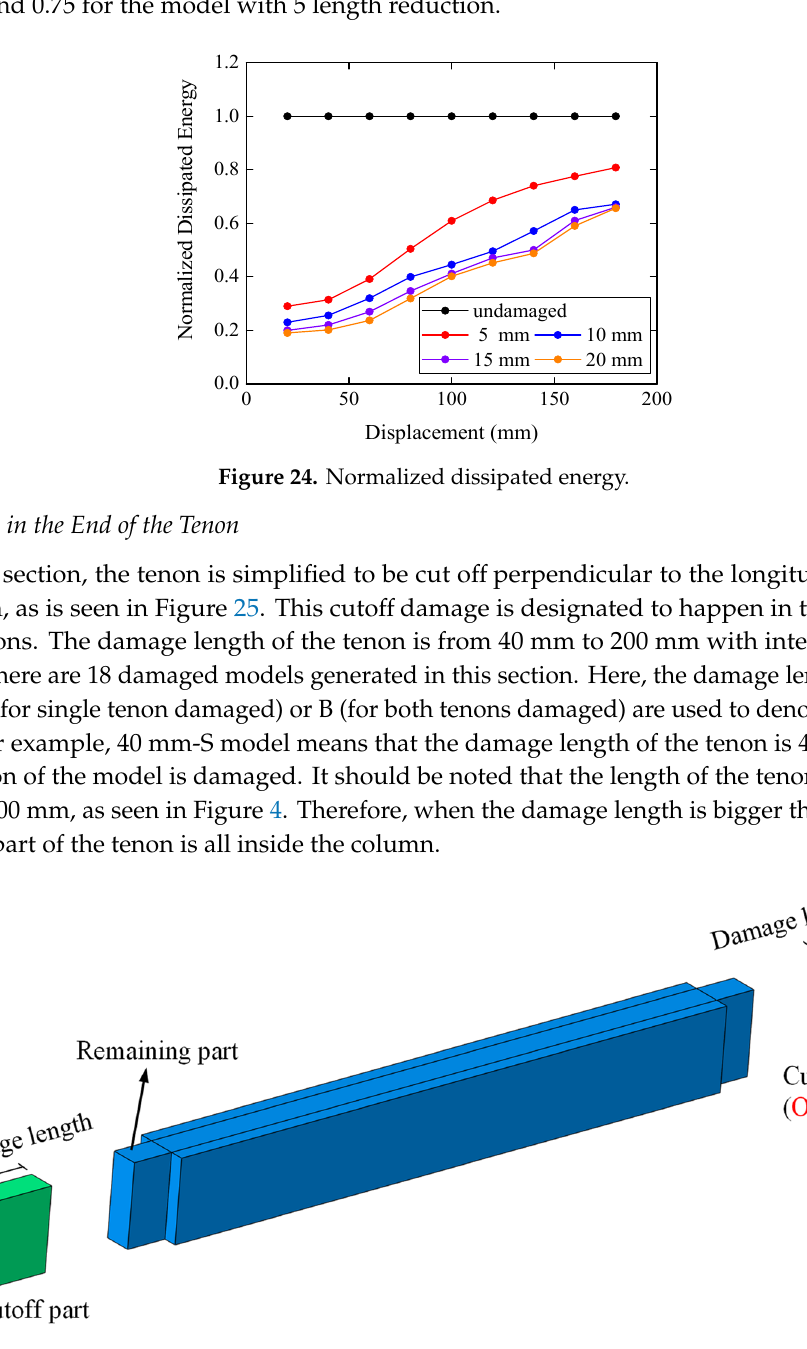
Figure 25. Damage in the end of the tenon.